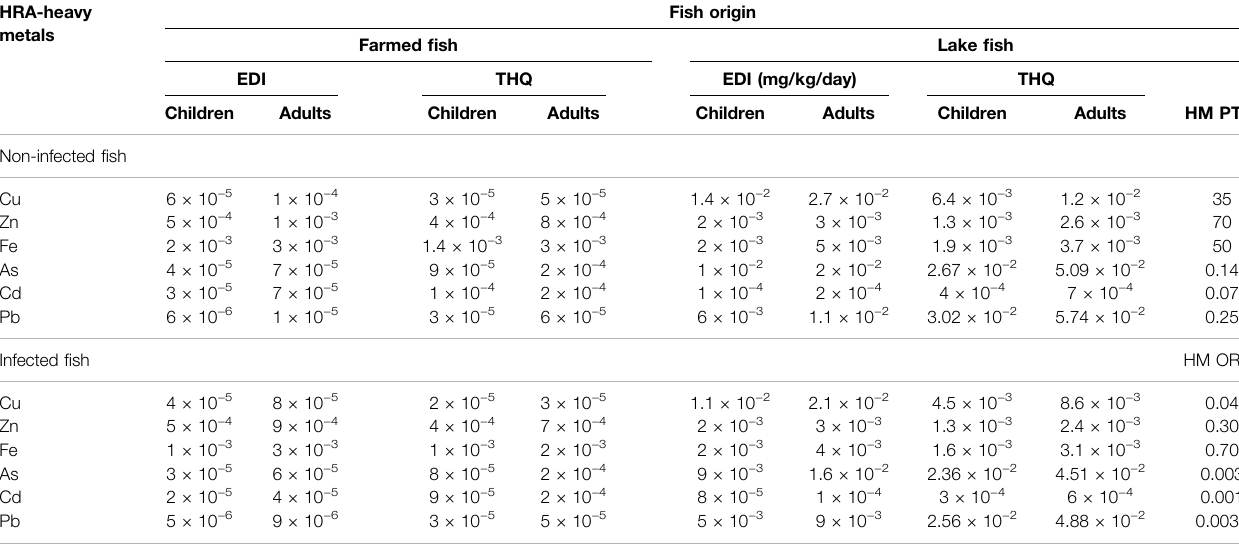
TABLE 9 | Estimated daily intake (EDI, mg/kg/day) and target hazard quotients (THQ) for HMs in muscles of farmed and lake O. niloticus . HRA-heavy metals